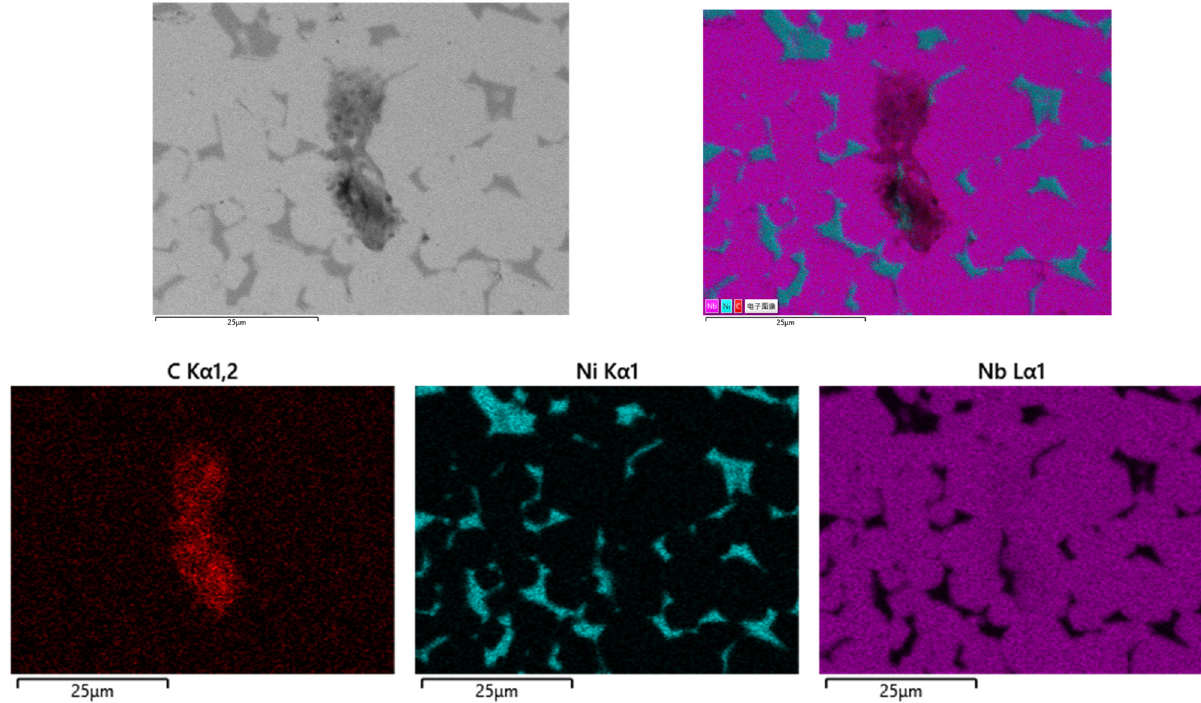
Figure 5: EDS map scanning of NbC – 10Ni cermets sintered at 1,450°C.